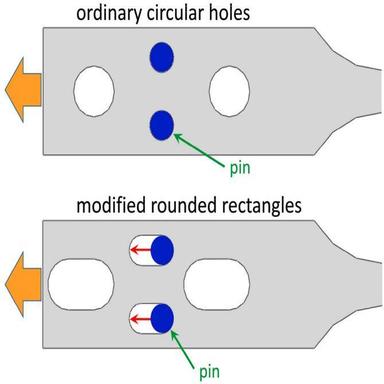
Modification of grip condition.